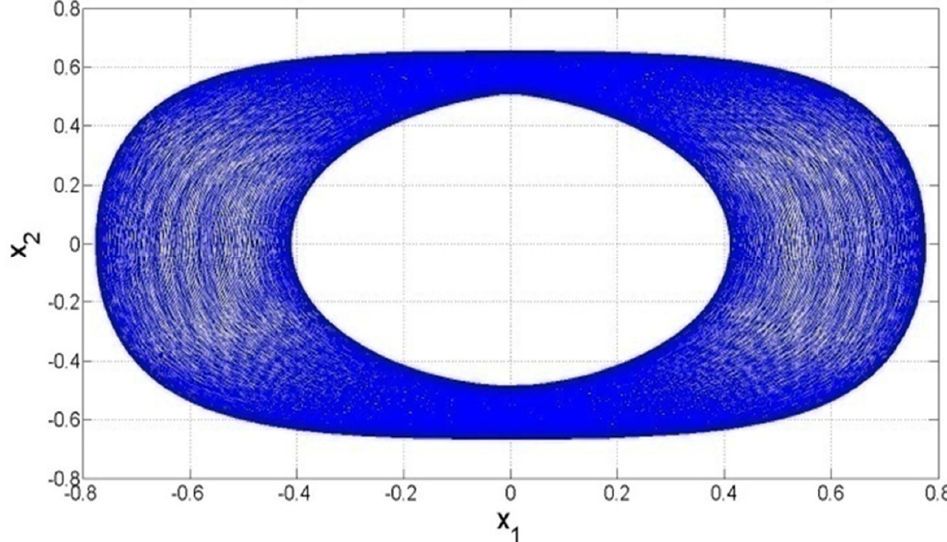
Figure 3. Chaotic behavior of a GLT Fuzzy Q-CNN system with extra nonlinear terms. CASE I: Parameter b 3 is unknown